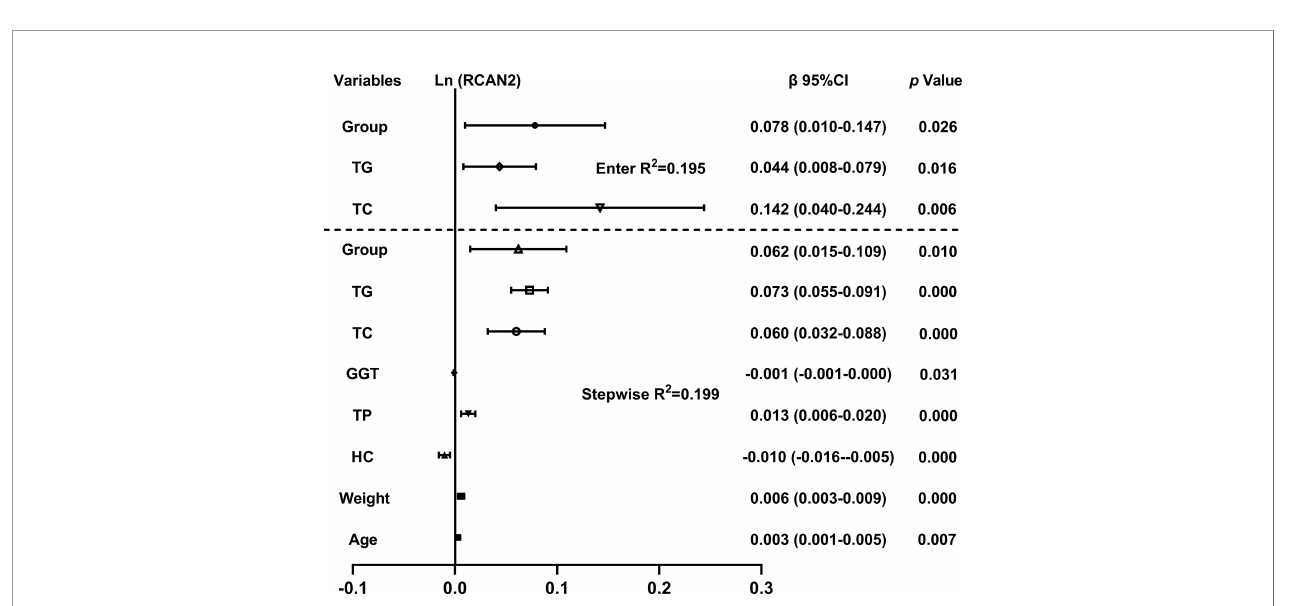
FIGURE 2 | Multiple regression analysis of variables independently related to serum RCAN2 concentrations in all subjects. The regression coef fi cients ( b ) and 95% con fi dent interval (CI) from linear regression analysis were displayed. Serum RCAN2 concentrations were ln-transformed before analysis. The statistic of group: 1=NW, 2=OW, 3=OB.